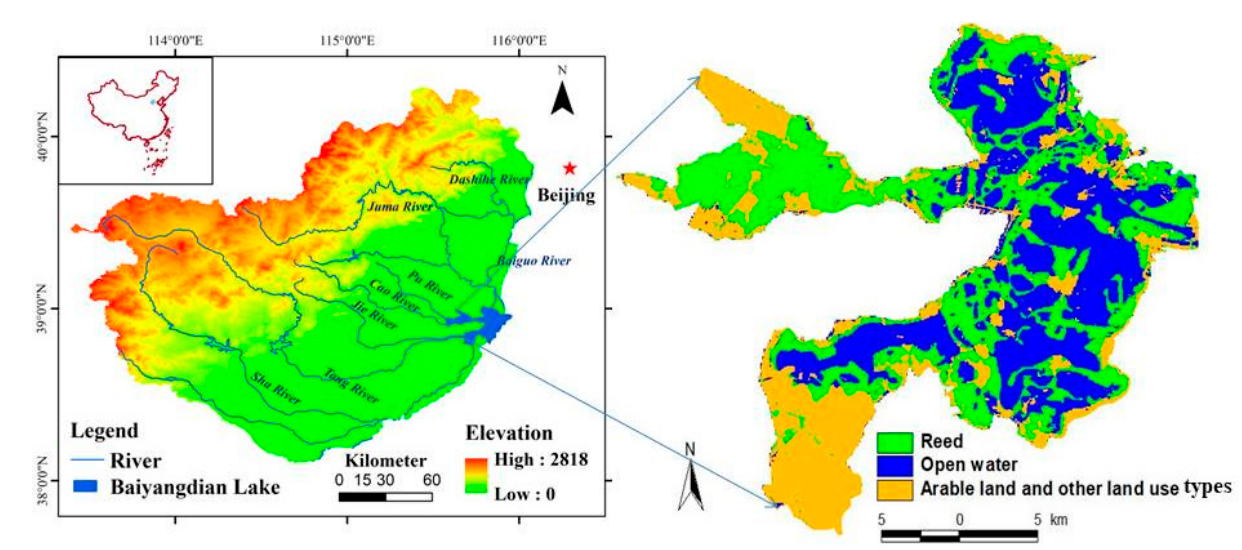
Figure 1. Baiyangdian Lake location.